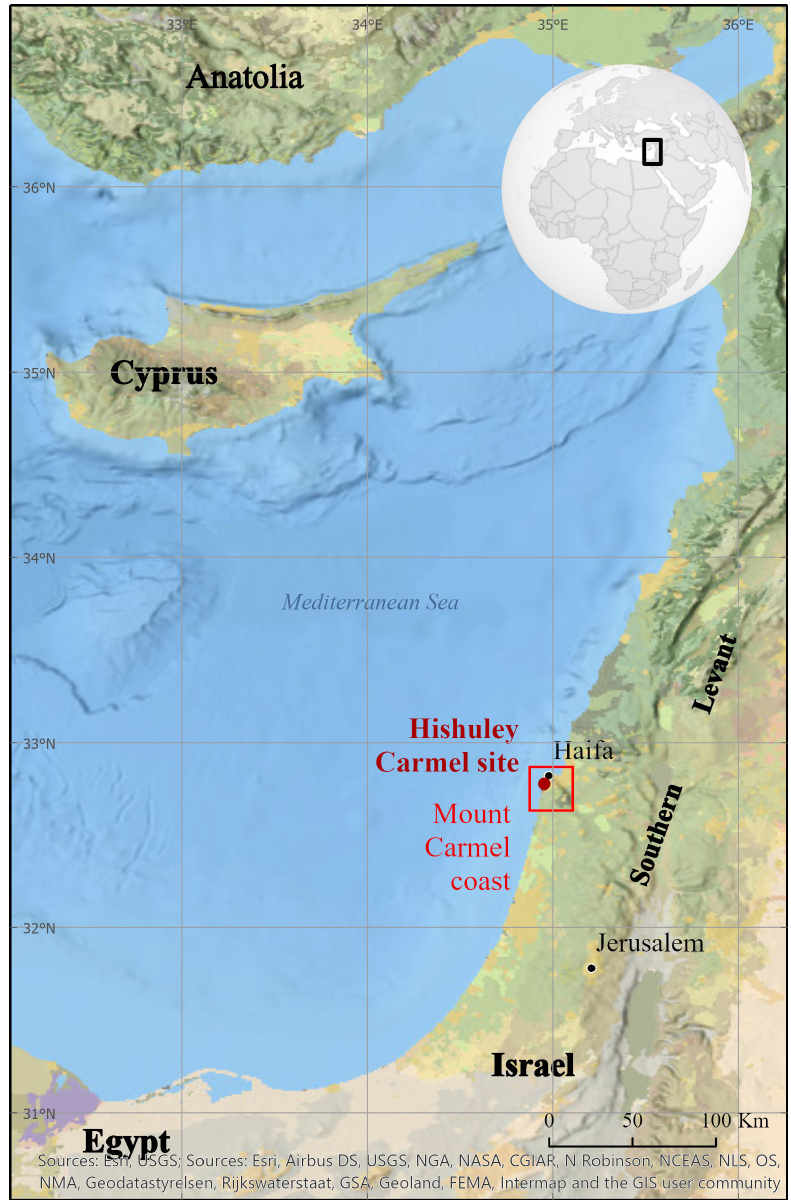
Figure 1. Location of Hishuley Carmel site (Israel).